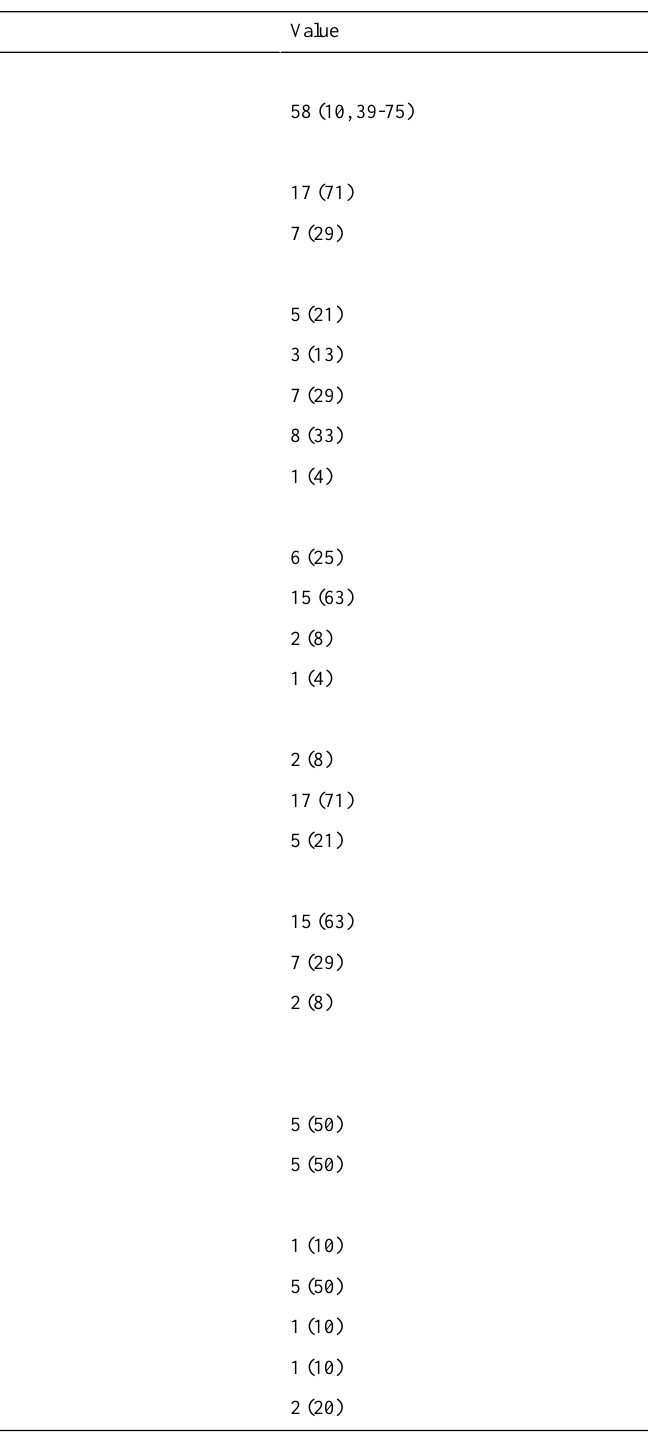
Table 1. Participant demographic information